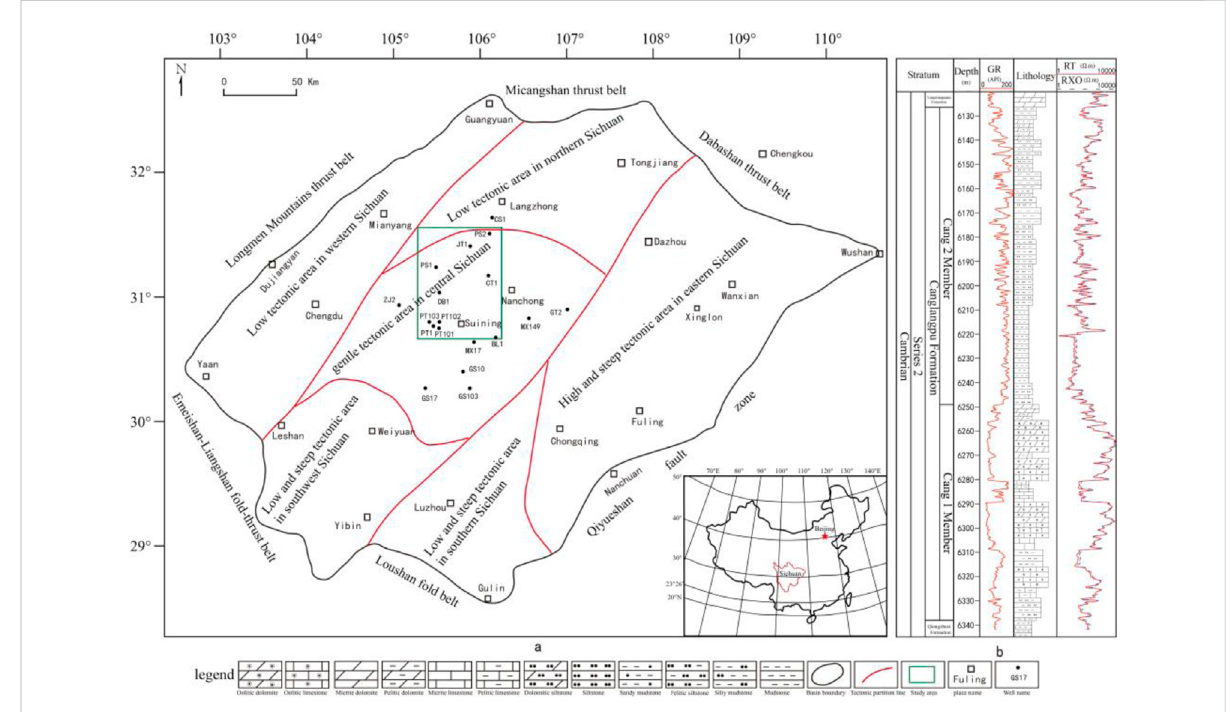
FIGURE 1 Location and comprehensive stratigraphic histogram of the study area. (A) Structural unit division of the Sichuan Basin (modi fi ed from Reference Hu et al., (2021)); (B) Lithologic histogram of the Canglangpu Formation in Well CT1. GR: natural gamma ray; Rt: true formation resistivity; Rxo: fl ushed zone formation